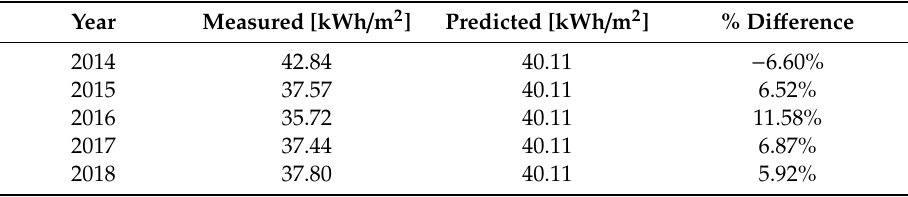
Table 6. Annual tenants’ consumption for di ff erent years, measured vs. predicted for an average